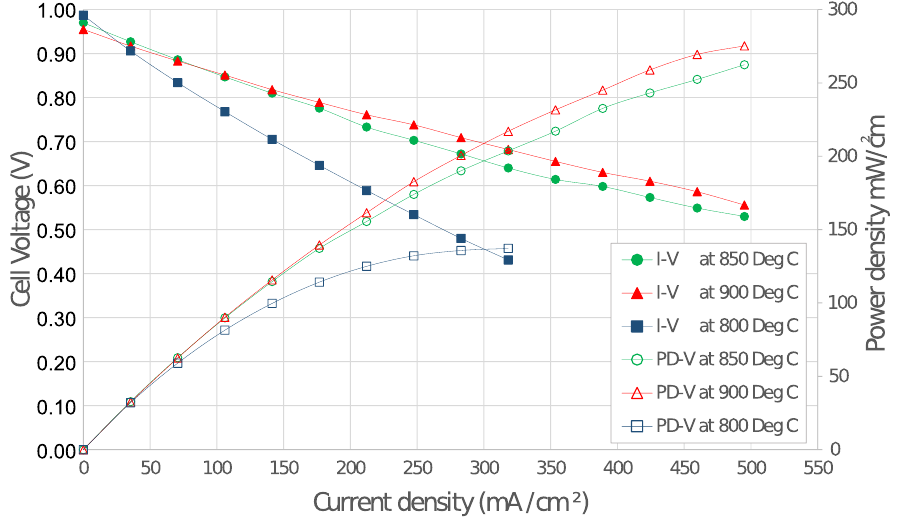
Figure 15. Voltage-current density and power-current density plots of the planar SOFC using air as oxidant—While using air as an oxidant (21% oxygen), it is observed that at low current densities very little difference in the performances of the cells operating at 850 ◦ C and at 900 ◦ C is observed. However, the cell operated at 800 ◦ C exhibits very high ohmic